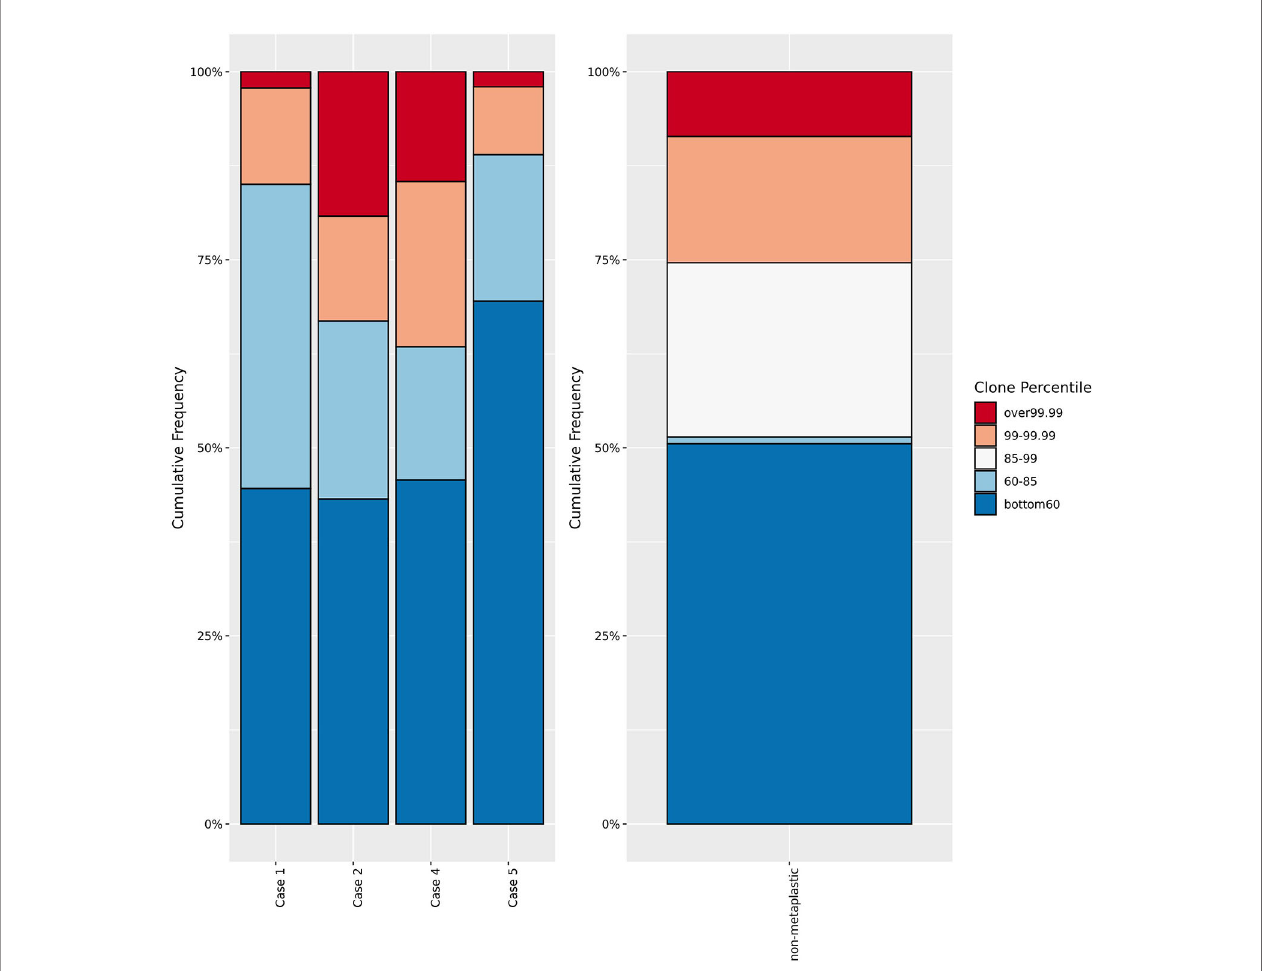
FIGURE 9 | T-cell receptor sequencing clone frequency. Comparison of T-cell receptor sequencing clone frequency for metaplastic cases versus non-metaplastic TNBC prior to treatment. No signi fi cant difference in the percentage of low, low-middle, high-middle, or high frequency clones is noted in comparing the metaplastic versus non-metaplastic cases, with Cases 2 and 4 appearing to have more high frequency clones, and Cases 1 and 5 having less. Cases 1 and 2 were responders while Cases 4 and 5 did not respond to